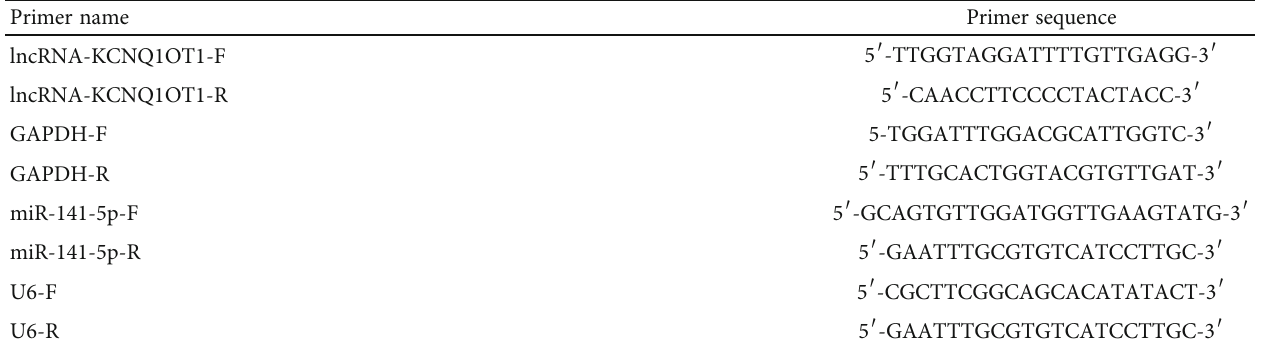
Table 1: Sequences of primers used for